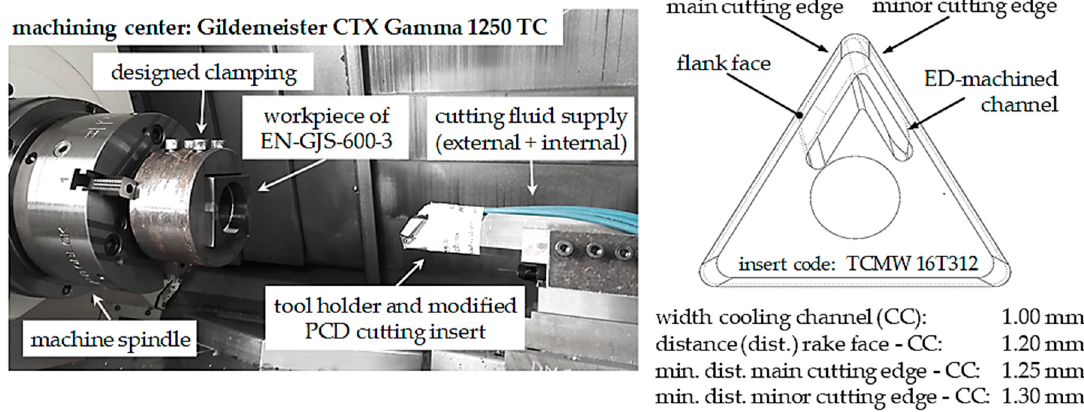
Figure 4. Experimental setup for initial cutting tests ( left ) and bottom view of CAD-model of applied, internally cooled cutting insert with characteristic measurements ( right ).